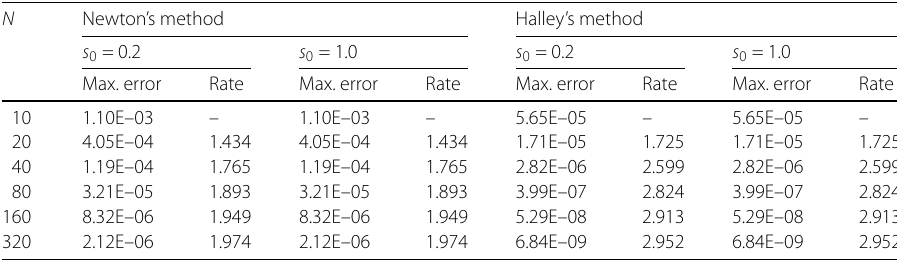
Table 5 Pointwise absolute errors in the maximum norm and computed rates of convergence versus the number of sub-intervals N in Example 4.2 as we set α 1 = 0.4, α 2 = 1.7, h = 0.01, m = 10 and no